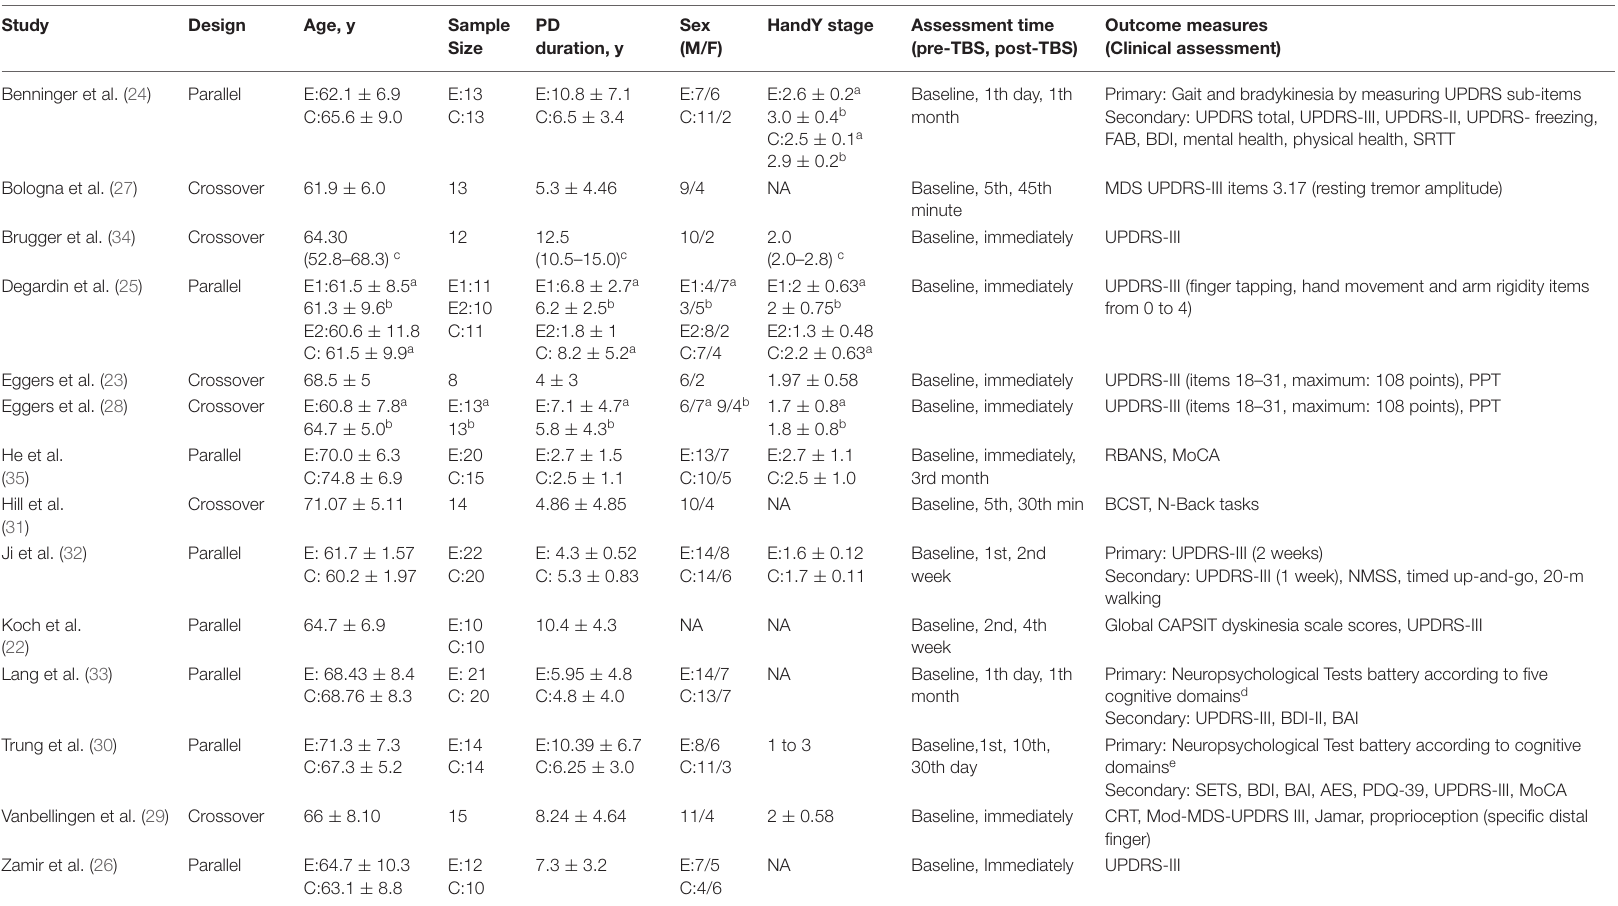
TABLE 1 | Characteristics of included studies.